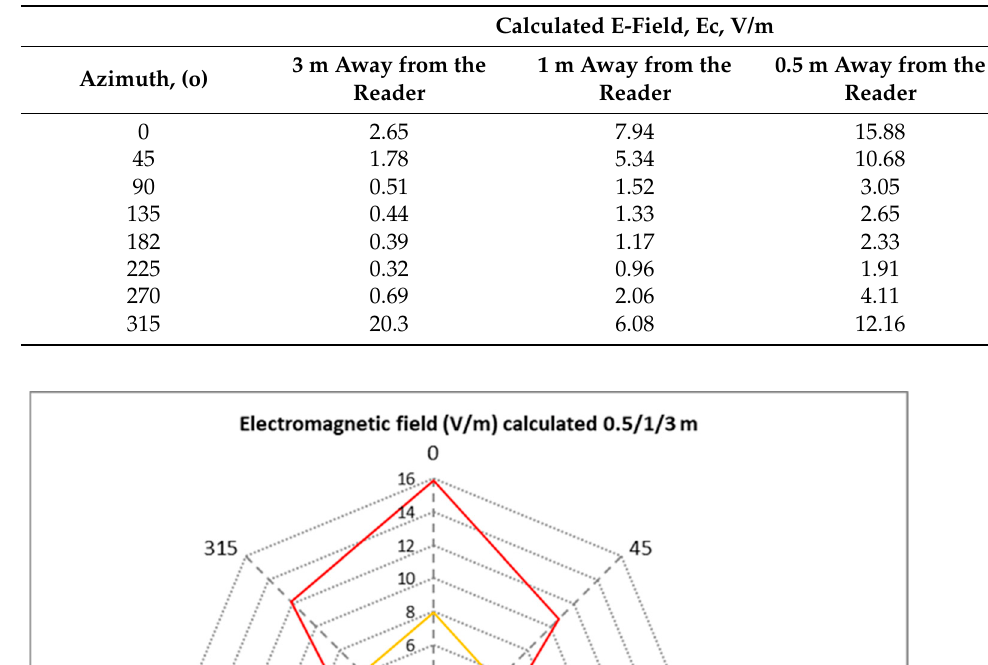
Table 7. The E-field peak values measured at 0.5 m, 1.0 m and 3.0 m from the AG-RFID reader [13].